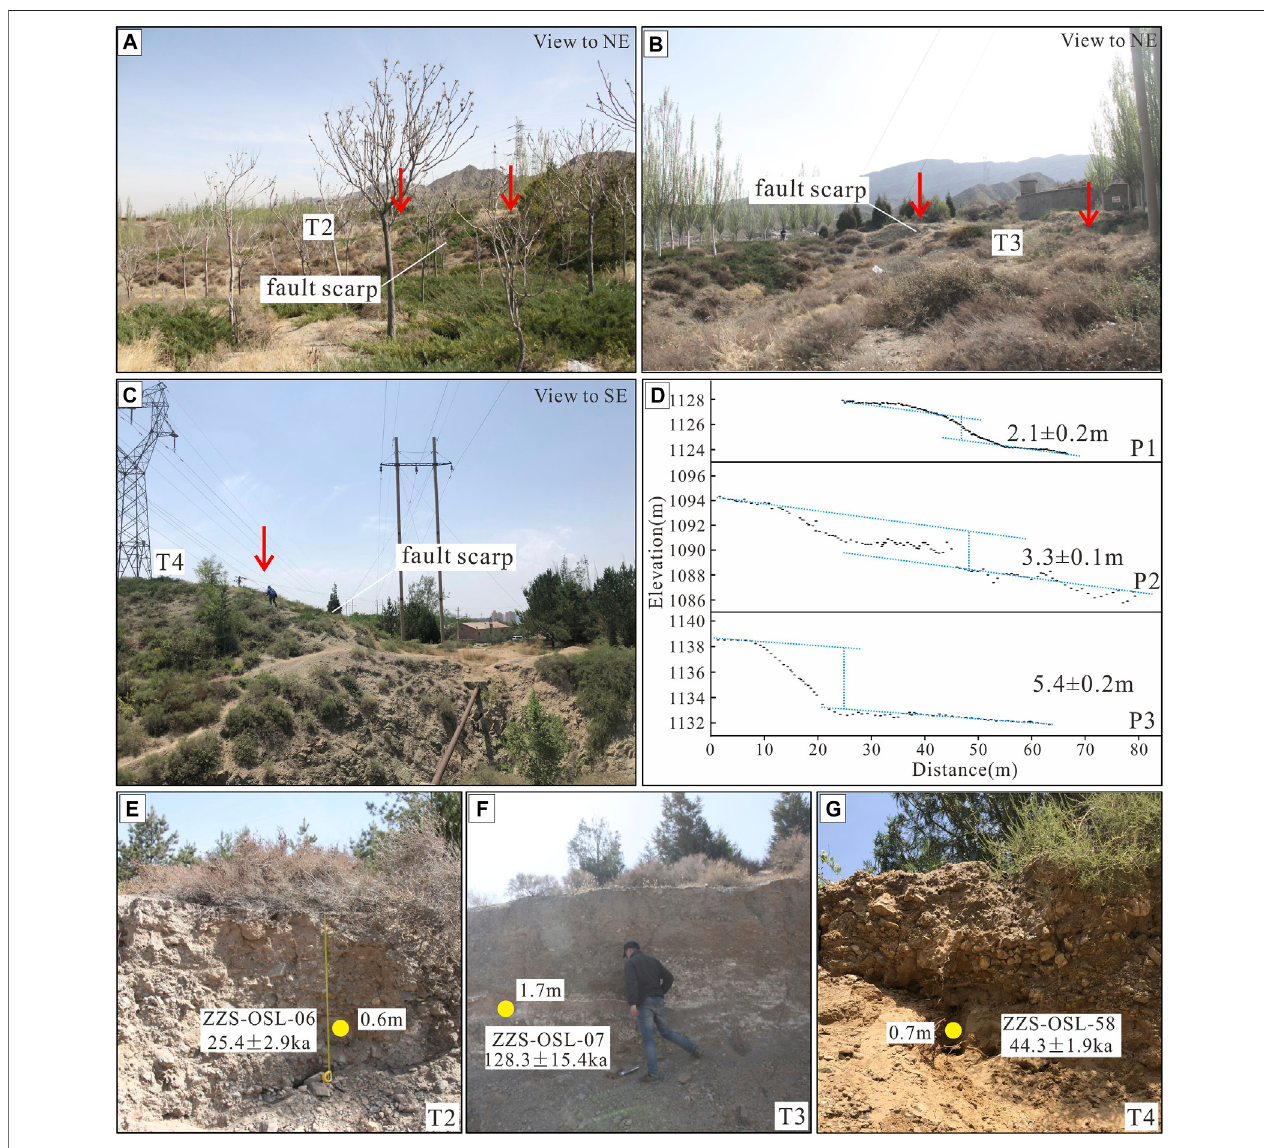
FIGURE 8 | (A) (B) , and (C) . Fault scarps displacing different levels of terraces observed in the fi eld (D) . Topographic pro fi les across the fault scarps on the T2, T3 and T4 terrace surfaces (E) (F) , and (G) . OSL sample pro fi les and ages for T2, T3, and T4